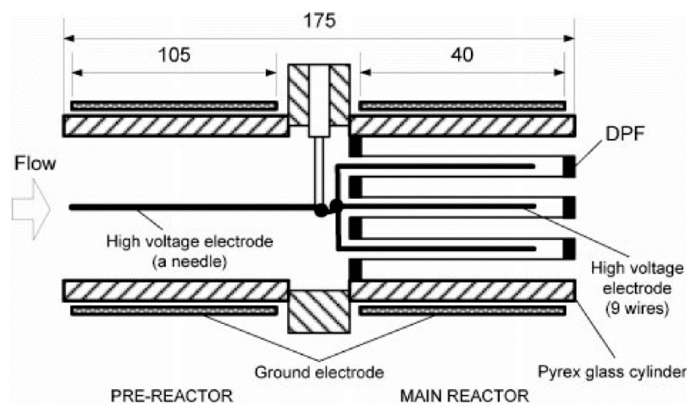
Figure 8. Dielectric barrier discharge reactor with honeycomb. Reprinted from Reference [86], with permission from Taylor & Francis Ltd.